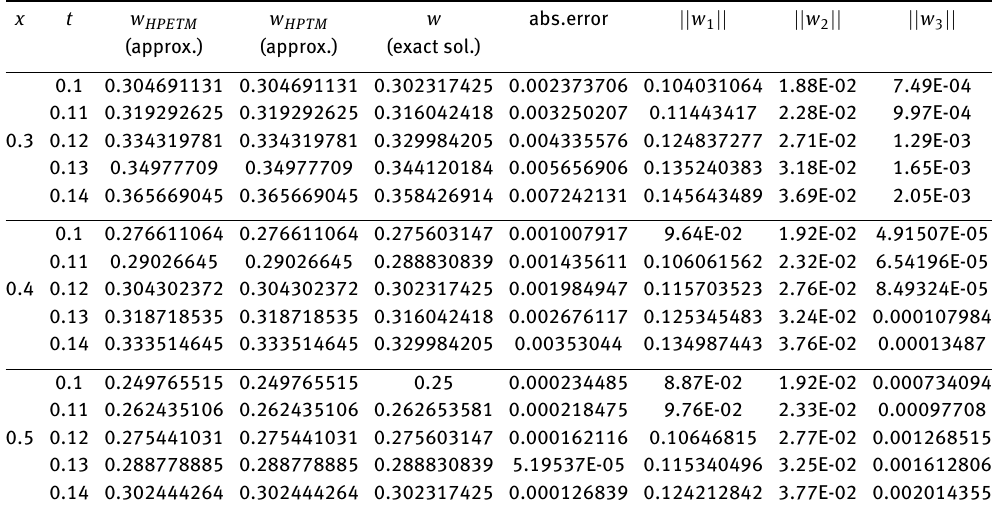
Table 1: Approximate solution of Fisher’s equation (6.1) and (8.1) up to fourth order( when α = 1 )